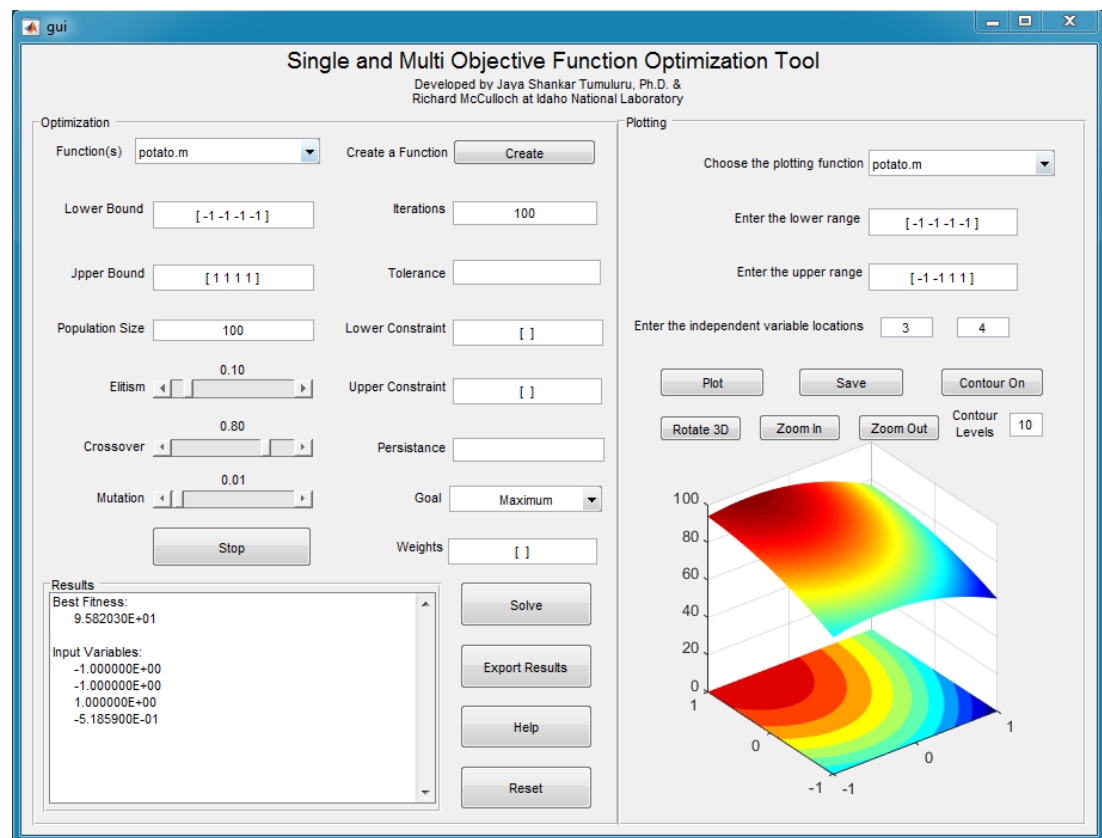
Figure 5. The user front-end of the Multi-Objective Optimization Tool. Table 7. Results for the case study on the anthocyanin yield.